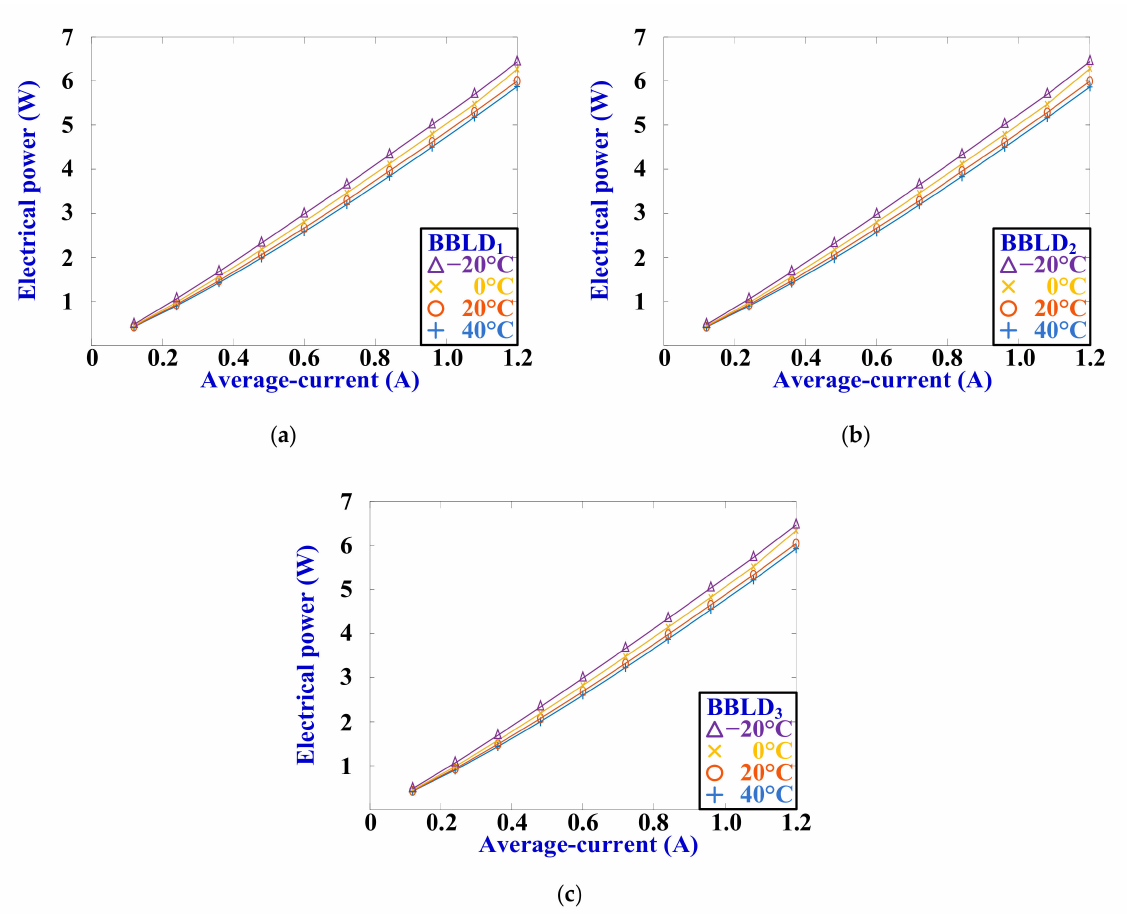
Figure 9. Electrical power ( P e ( avg ) ) variations in average current modulation. ( a ) BBLD 1 . ( b ) BBLD 2 . ( c ) BBLD 3 .